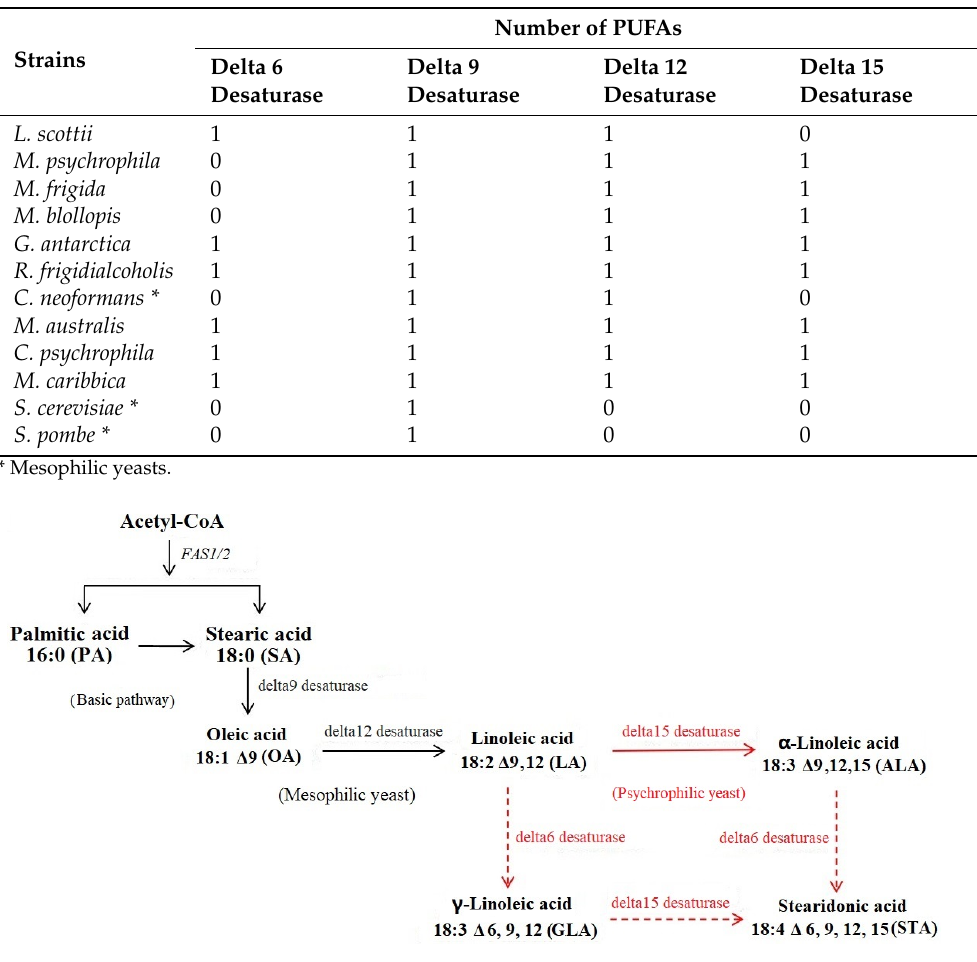
Figure 1. Proposed PUFA pathways in mesophilic and psychrophilic yeasts.